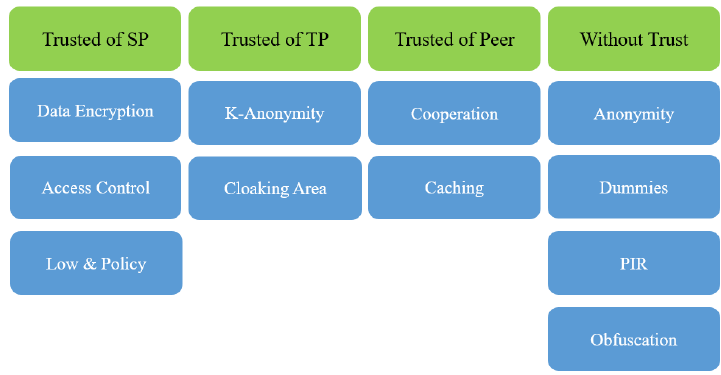
Figure 5. Classification of IoT privacy